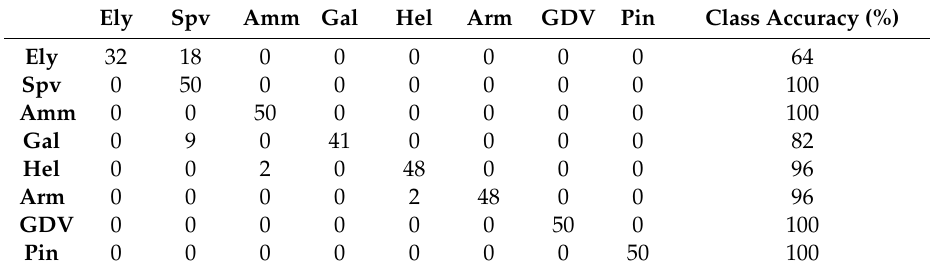
Table 5. Confusion matrix of the second RF classifier for the eight vegetation classes (after merging Ota and SPV).